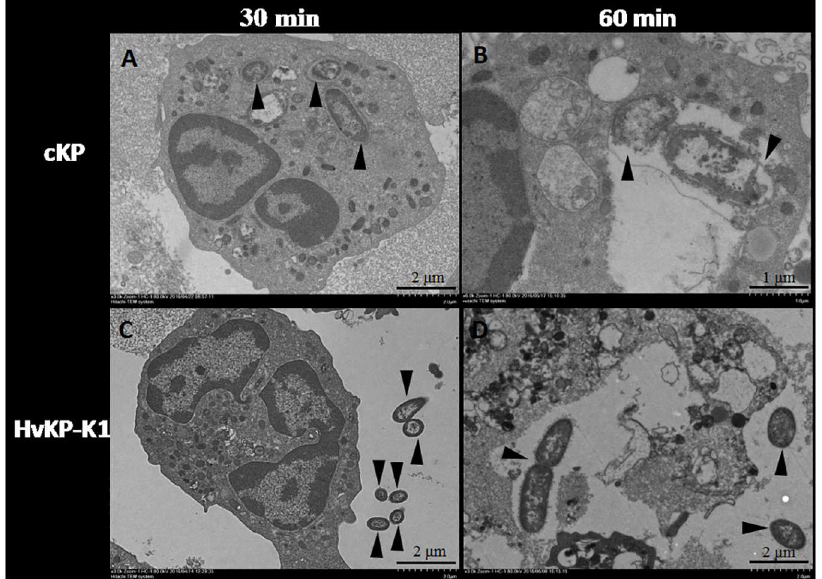
Fig 3. Examination under transmission electron microscopy. Phagocytosed cKP (3 isolates, A) and HvKP-K1 (3 isolates, C) by neutrophils at 30 min ( × 3K); lysed cKP lack of intact cell wall (3 isolates, B) and binary fission multiplyingHvKP-K1 (3 isolates, D) at 60min ( × 6K). Bacteria were indicatedby black